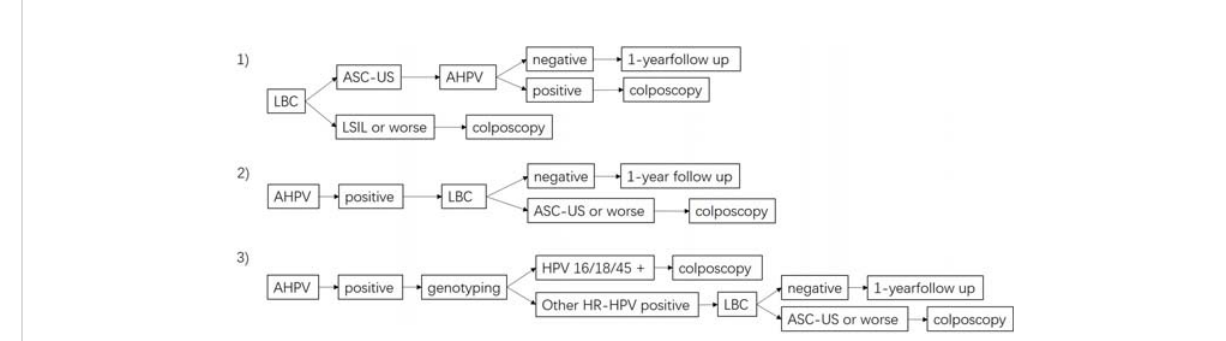
FIGURE 1 Flow diagram of the different triage strategies. 1) LBC-AHPV triage, 2) AHPV-LBC triage, and 3) AHPV genotyping with re fl ex LBC triage. LBC, liquid-based cytology; AHPV, Aptima human papillomavirus.